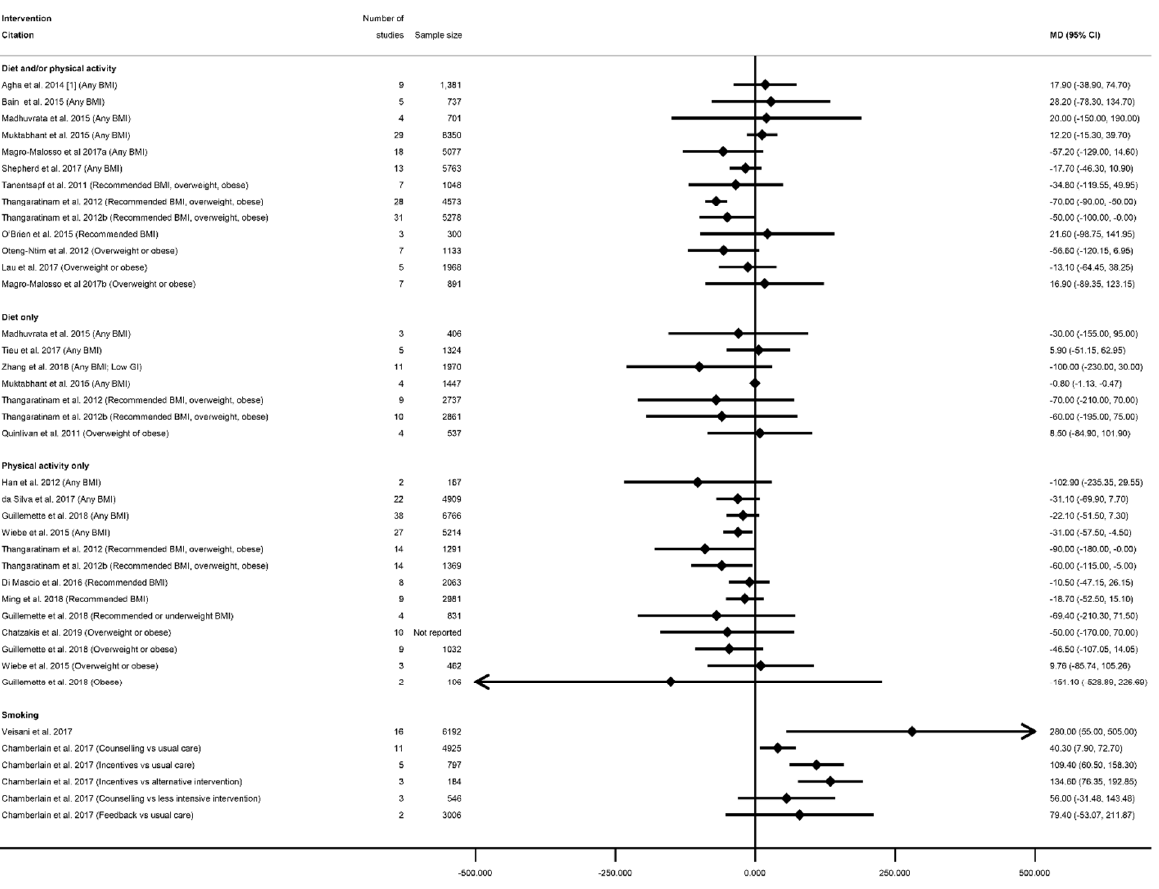
Figure 10. Forest plot of meta-analysis results for birthweight.